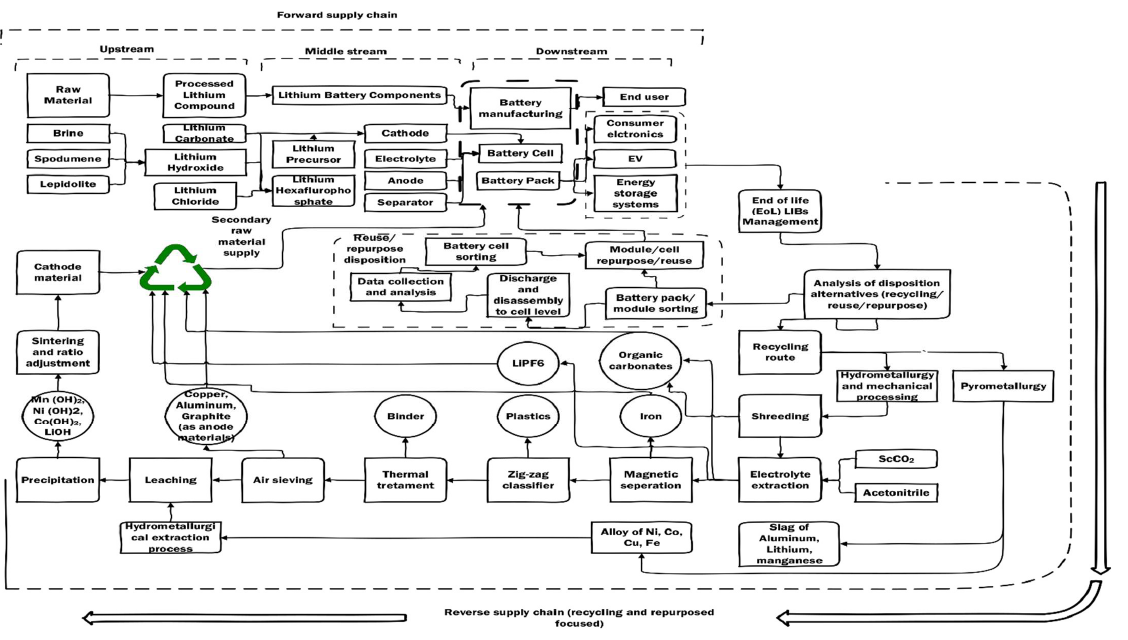
Figure 2. General flow diagram of the recycling process of LIBs, compiled and redrawn from [17–20]. Table 1. Summary of the previously published review articles on recycling and circular economy.